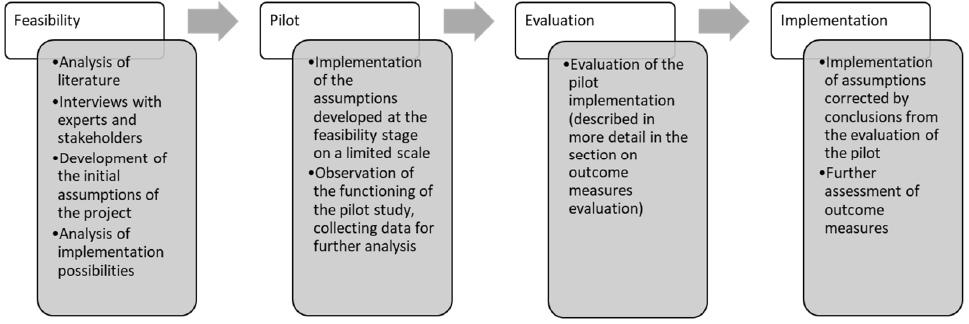
Figure 1. ICM implementation details. Made by the authors. Based on: